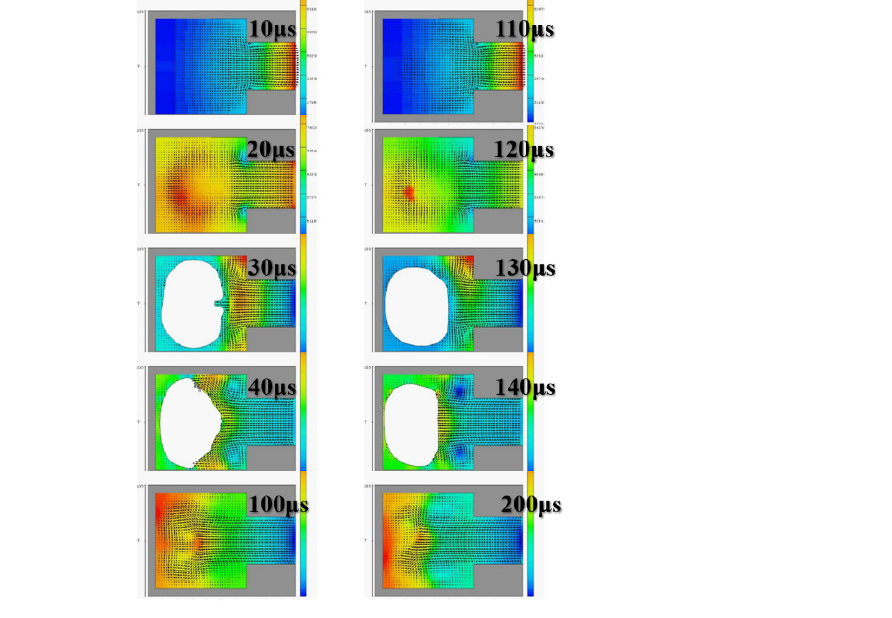
Figure 6. Calculate and simulate water in a single-channel spray chamber with a